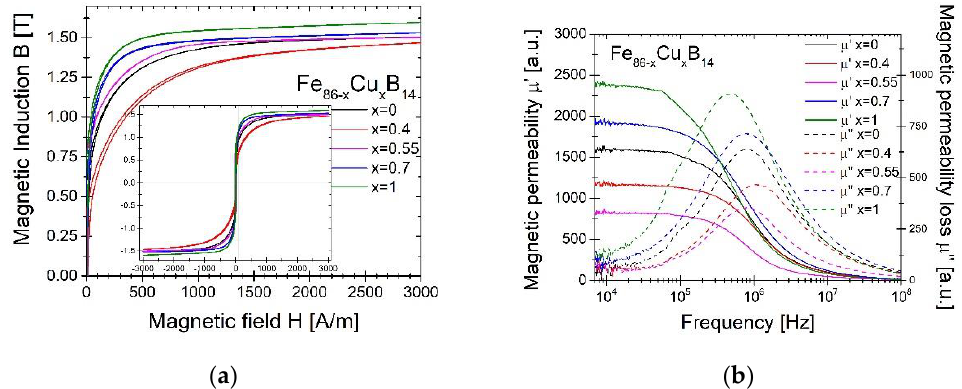
Figure 6. Hysteresis loops: ( a ) real µ’ and imaginary µ” part of permeability; ( b ) dependence in the function of frequency 10 4 –10 8 Hz for samples annealed at the optimum Ta.